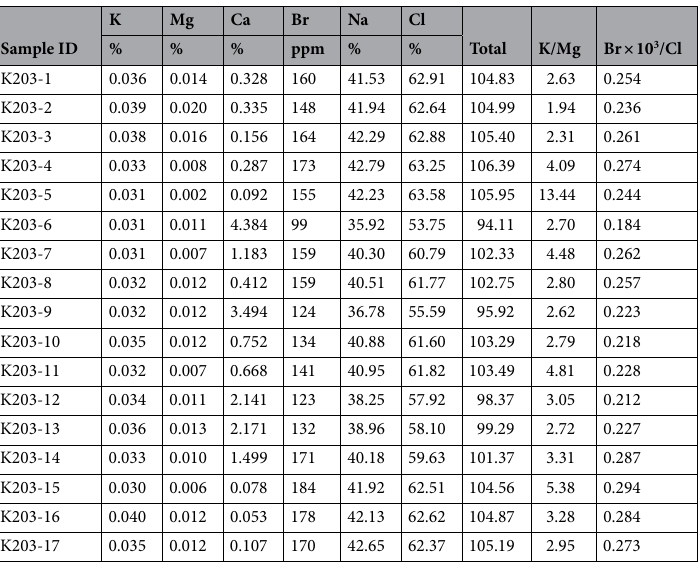
Table 1. K, Mg, Ca, Br, Na and Cl contents of halite samples from the Hole K203.